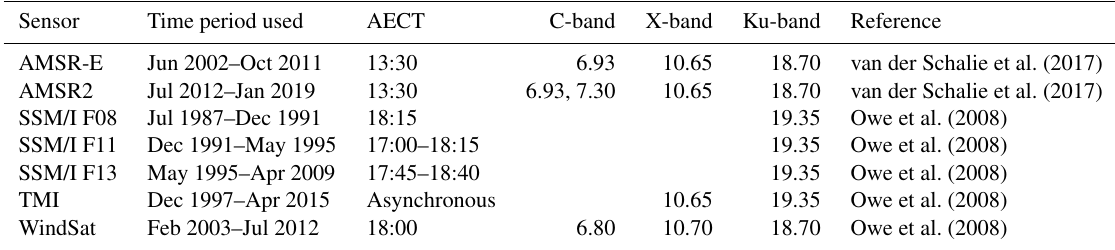
Table 1. The input VOD data sets used with their temporal coverage, local ascending equatorial crossing times (AECT), and used frequencies (GHz) for each